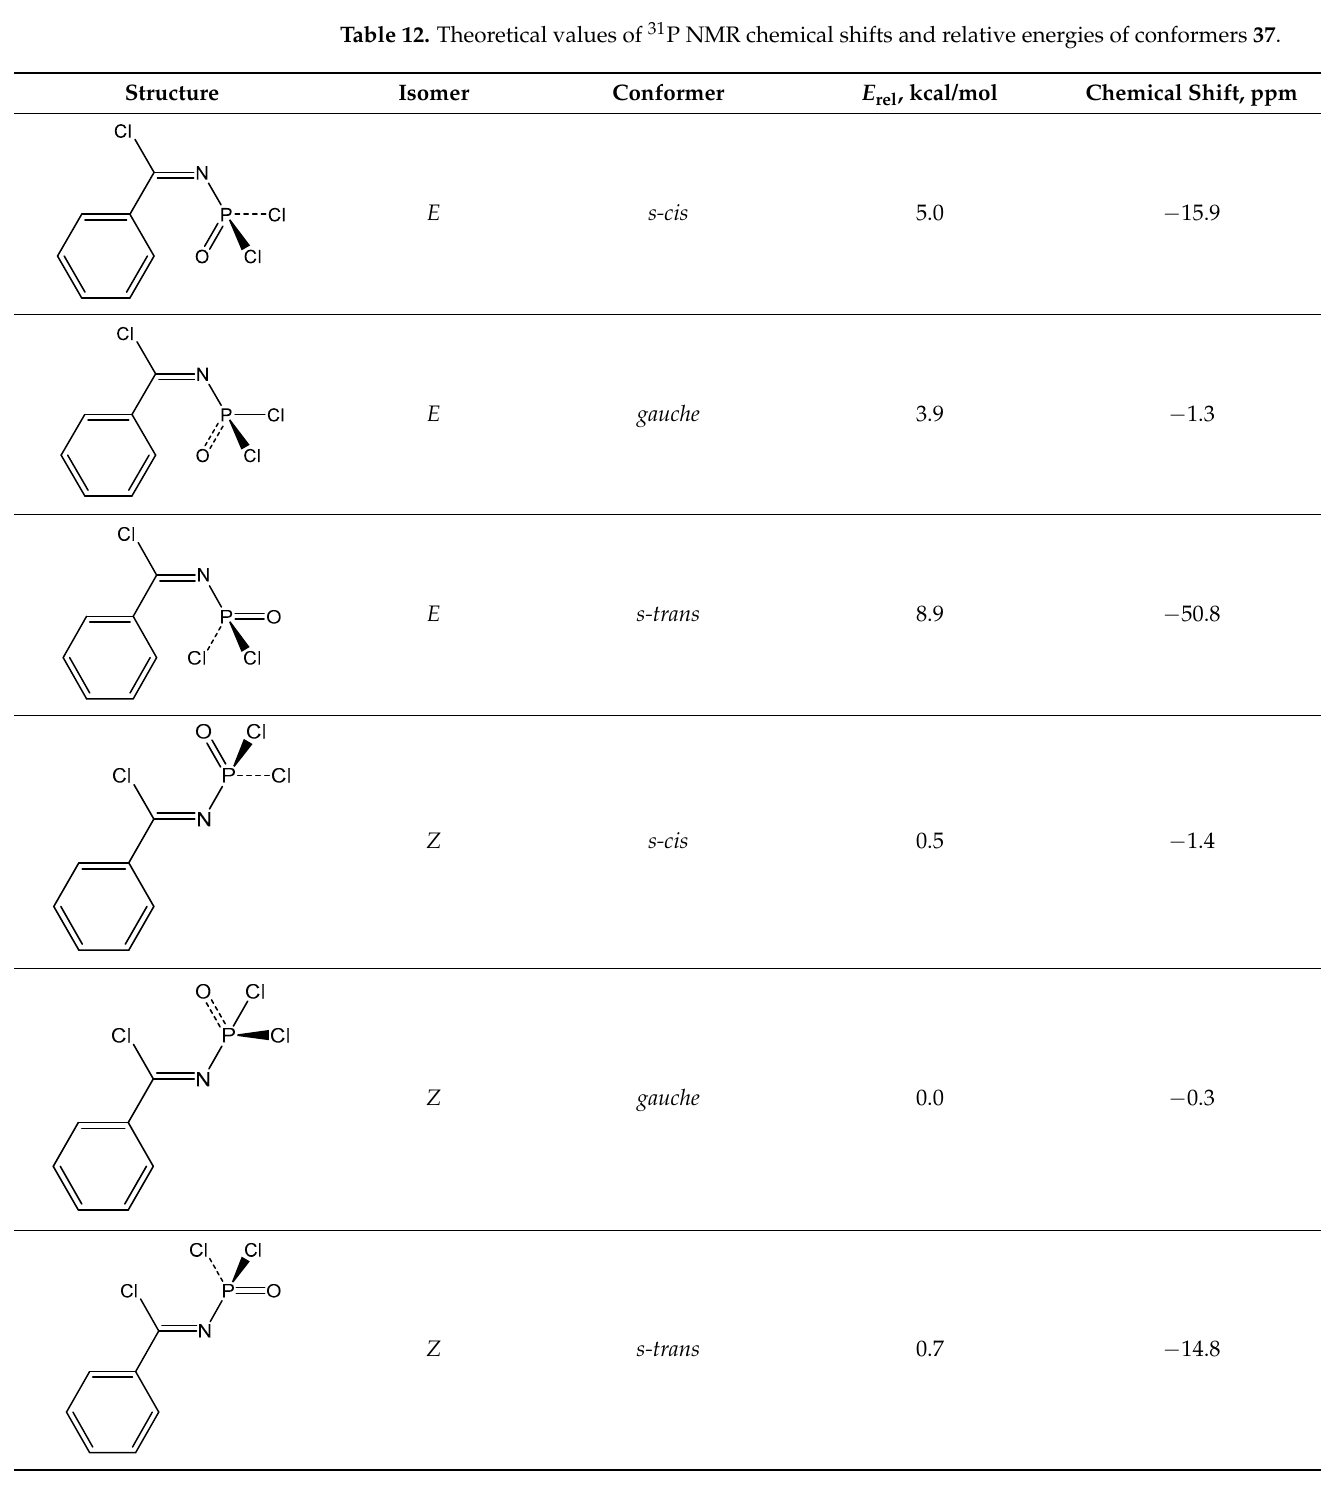
Table 13. Theoretical values of 31 P NMR chemical shifts and relative energies of conformers 38.